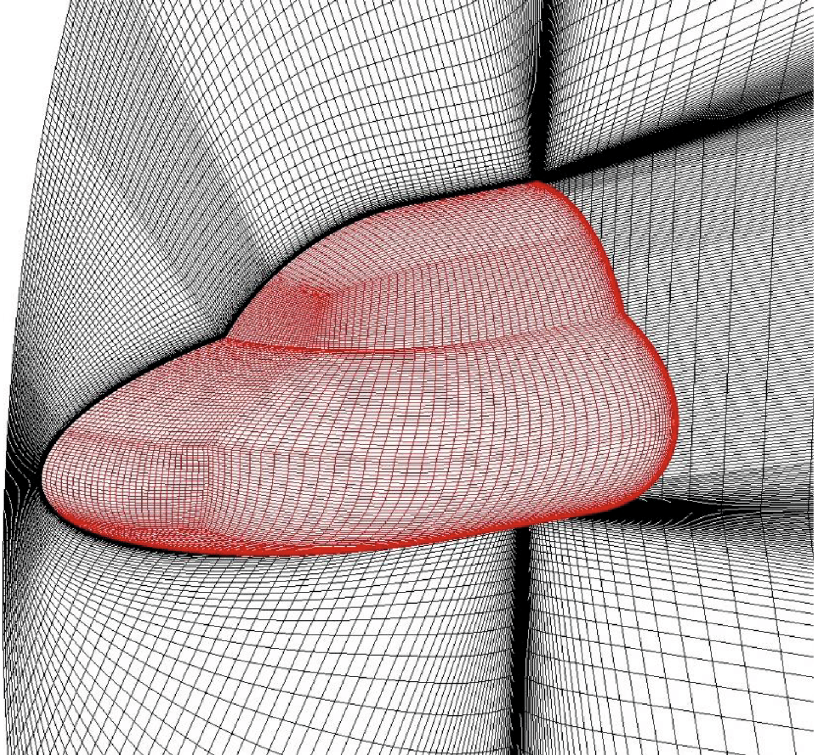
Figure 8: Illustration of the structured grid for the two validation cases.